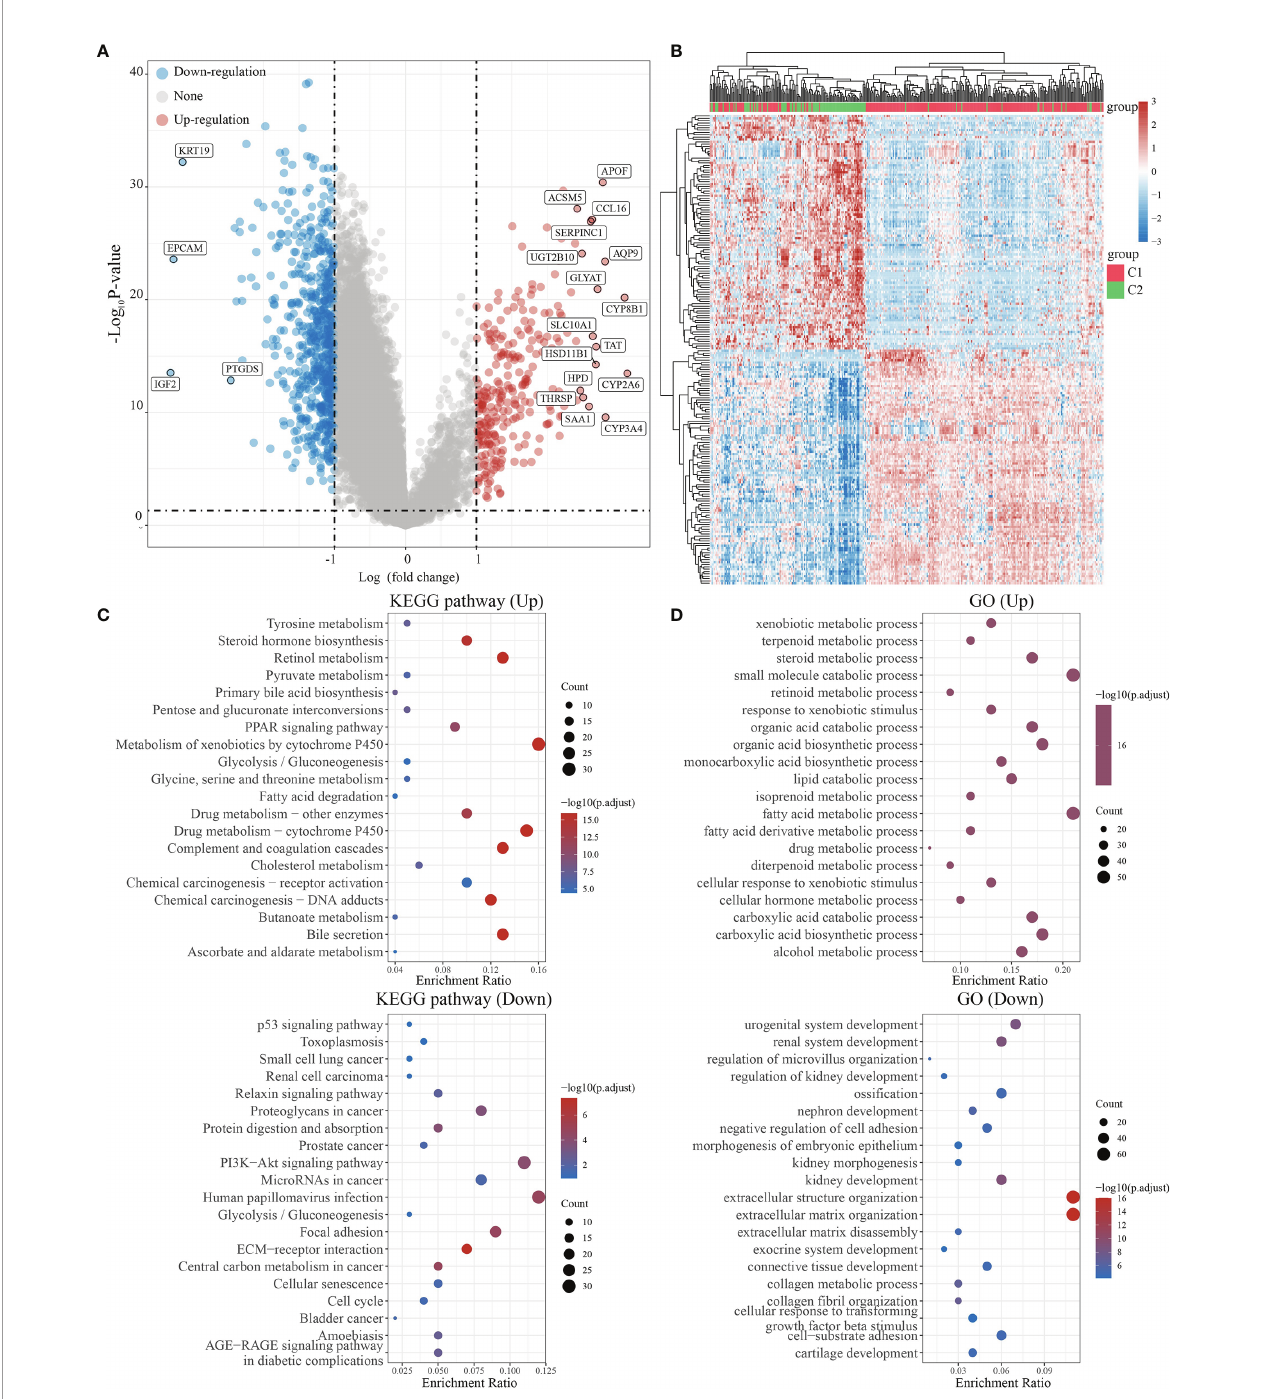
FIGURE 3 | Differential expression and enrichment analysis of C1 and C2. (A) The volcano plot shows the differential gene expression of C1 and C2 drawn with fold-change values and adjusted P. (B) Heat map showing differential gene expression (only 50 genes were displayed because of the large quantity of the genes). (C, D) KEGG and GO analysis showed the upregulated/downregulated pathways of the C1 compared with C2. P <0.05 or FDR<0.05 is considered to be